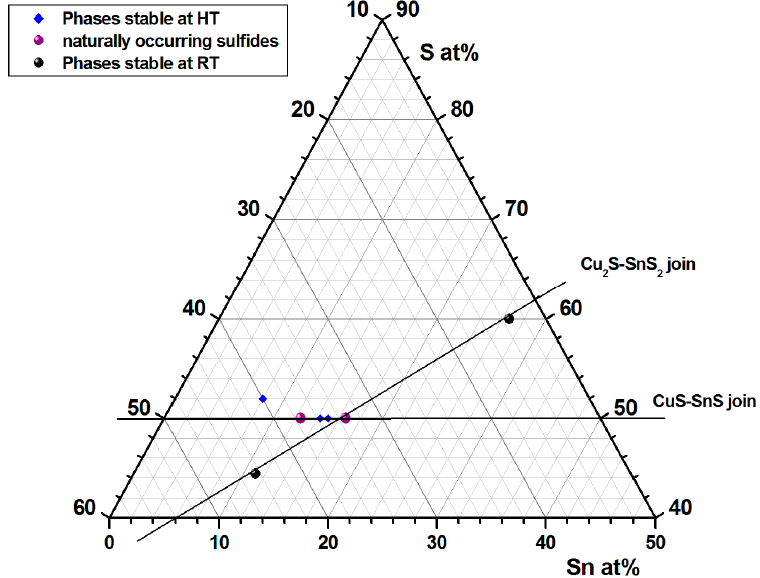
Figure 1. Ternary Cu–Sn–S system, reporting the phases found in nature (purple spheres), those reported as stable at room temperature (RT, black spheres) and those reported as stable at temperature values > 400 °C (HT, high temperature, blue diamonds).